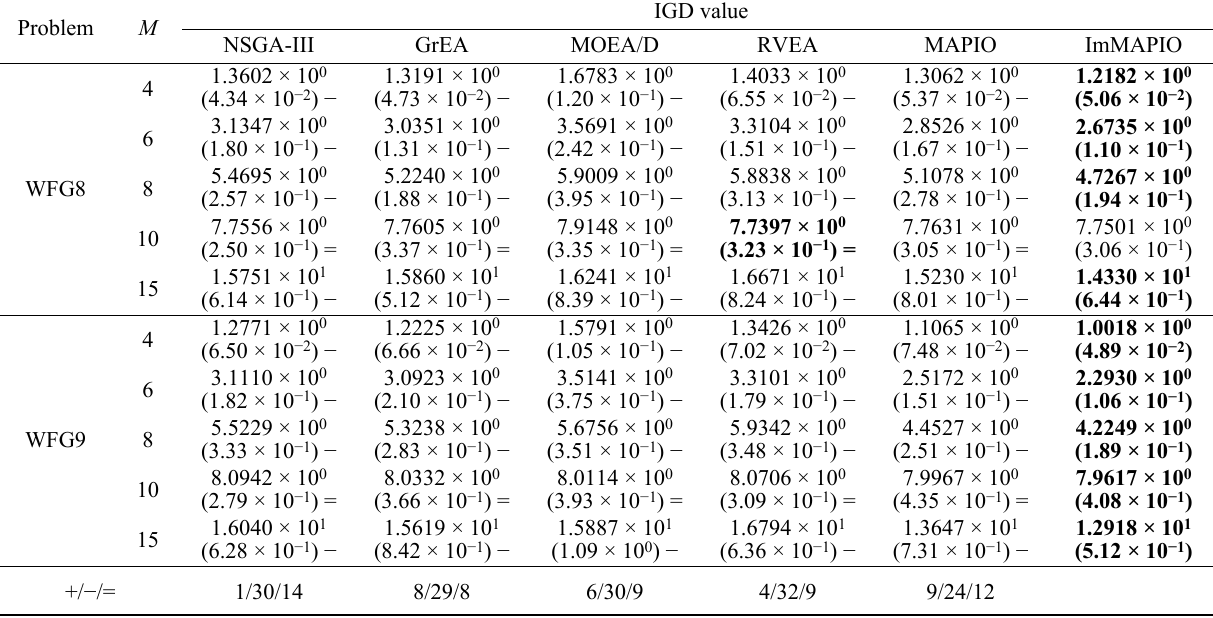
Table 4 IGD values of six algorithms for different objectives in the WFG test